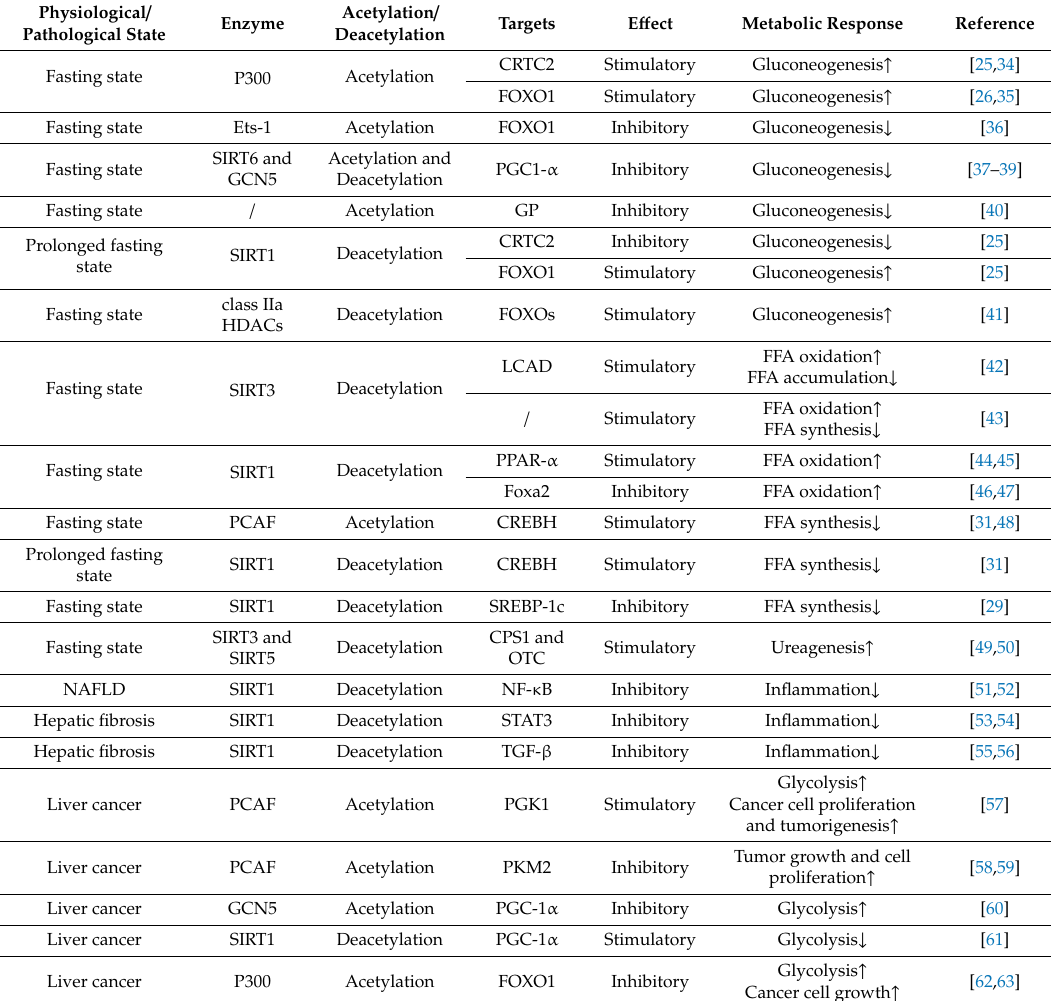
Table 1. Overview of the regulation of di ff erent targets related to hepatic metabolism via glucagon-induced acetylation in di ff erent physiological states. Physiological / Pathological